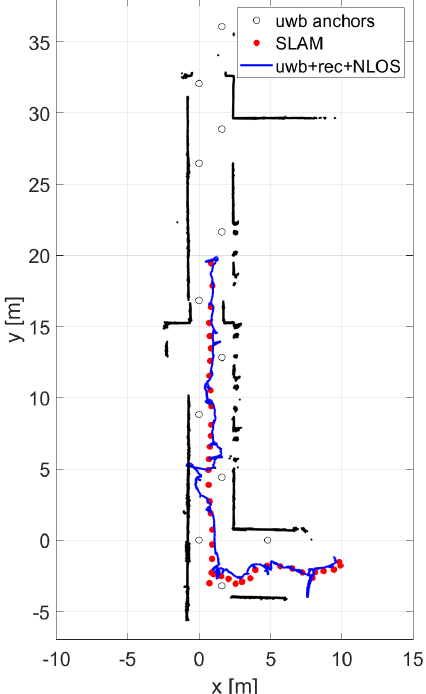
Figure 7. UWB+anchor recognition+NLOS detection positioning.